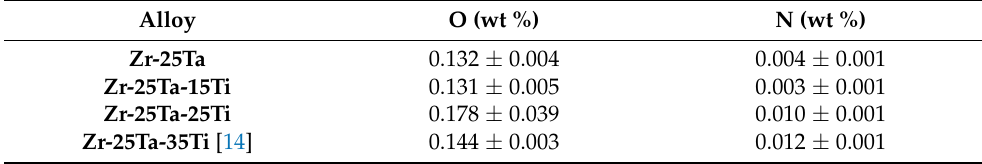
Table 2. Gas analysis of the produced Zr-25Ta-xTi alloys.